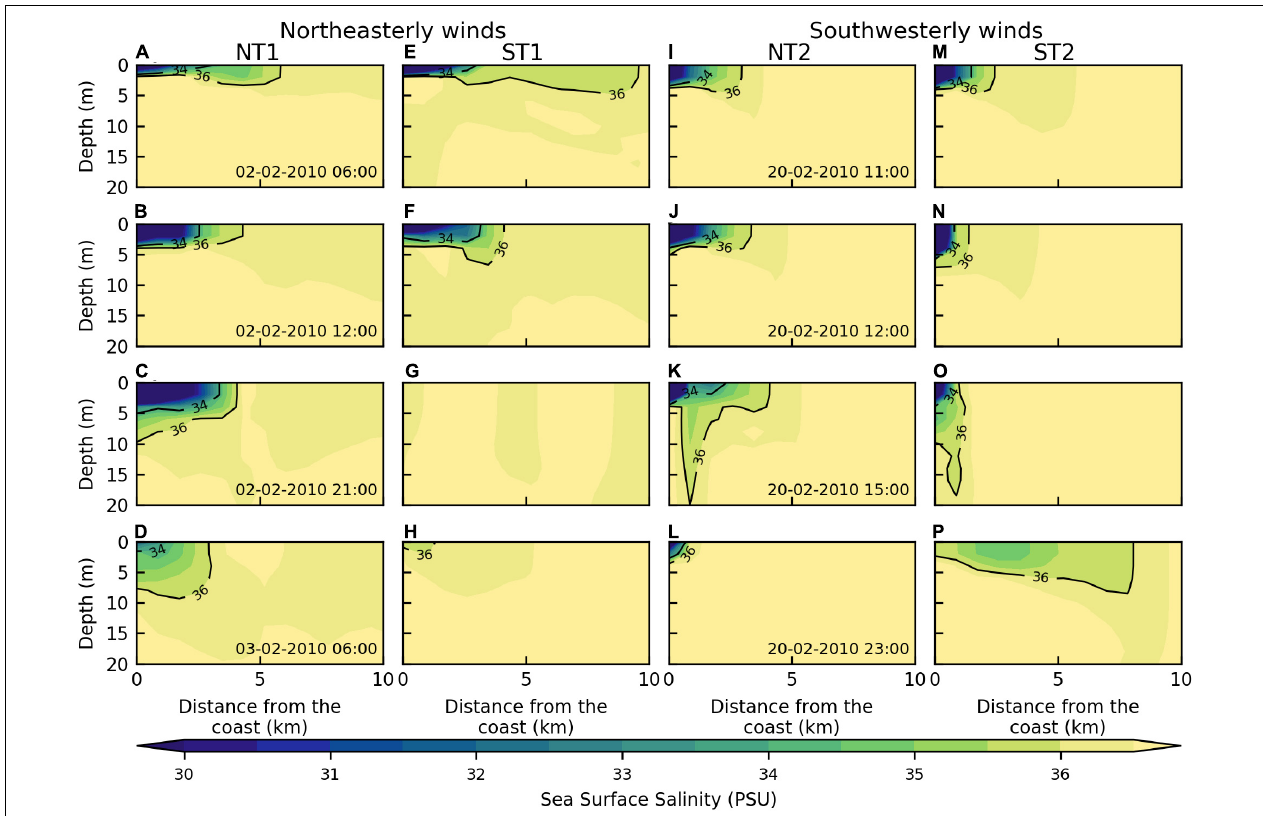
FIGURE 10 | Snapshots (same time steps as shown in Figure 8 ) of vertical variability of salinity with contours in transects (A–D) NT1 and (E–H) ST1 during northeasterly winds and (I–L) NT2 and (M–P) ST2 during southwesterly winds. See Figure 8 for transect